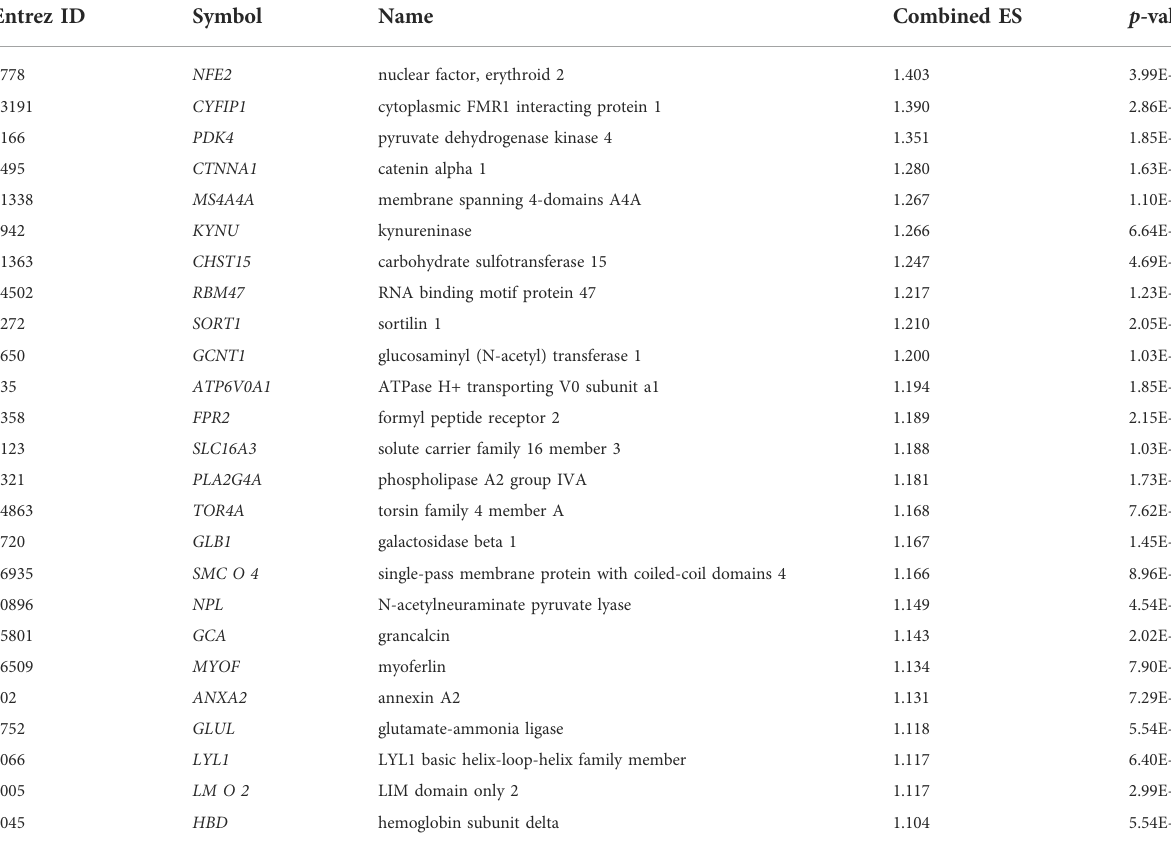
TABLE 2 The top 25 up-regulated genes (the highest ES) in the blood cells of PAH relative to normal samples. Entrez